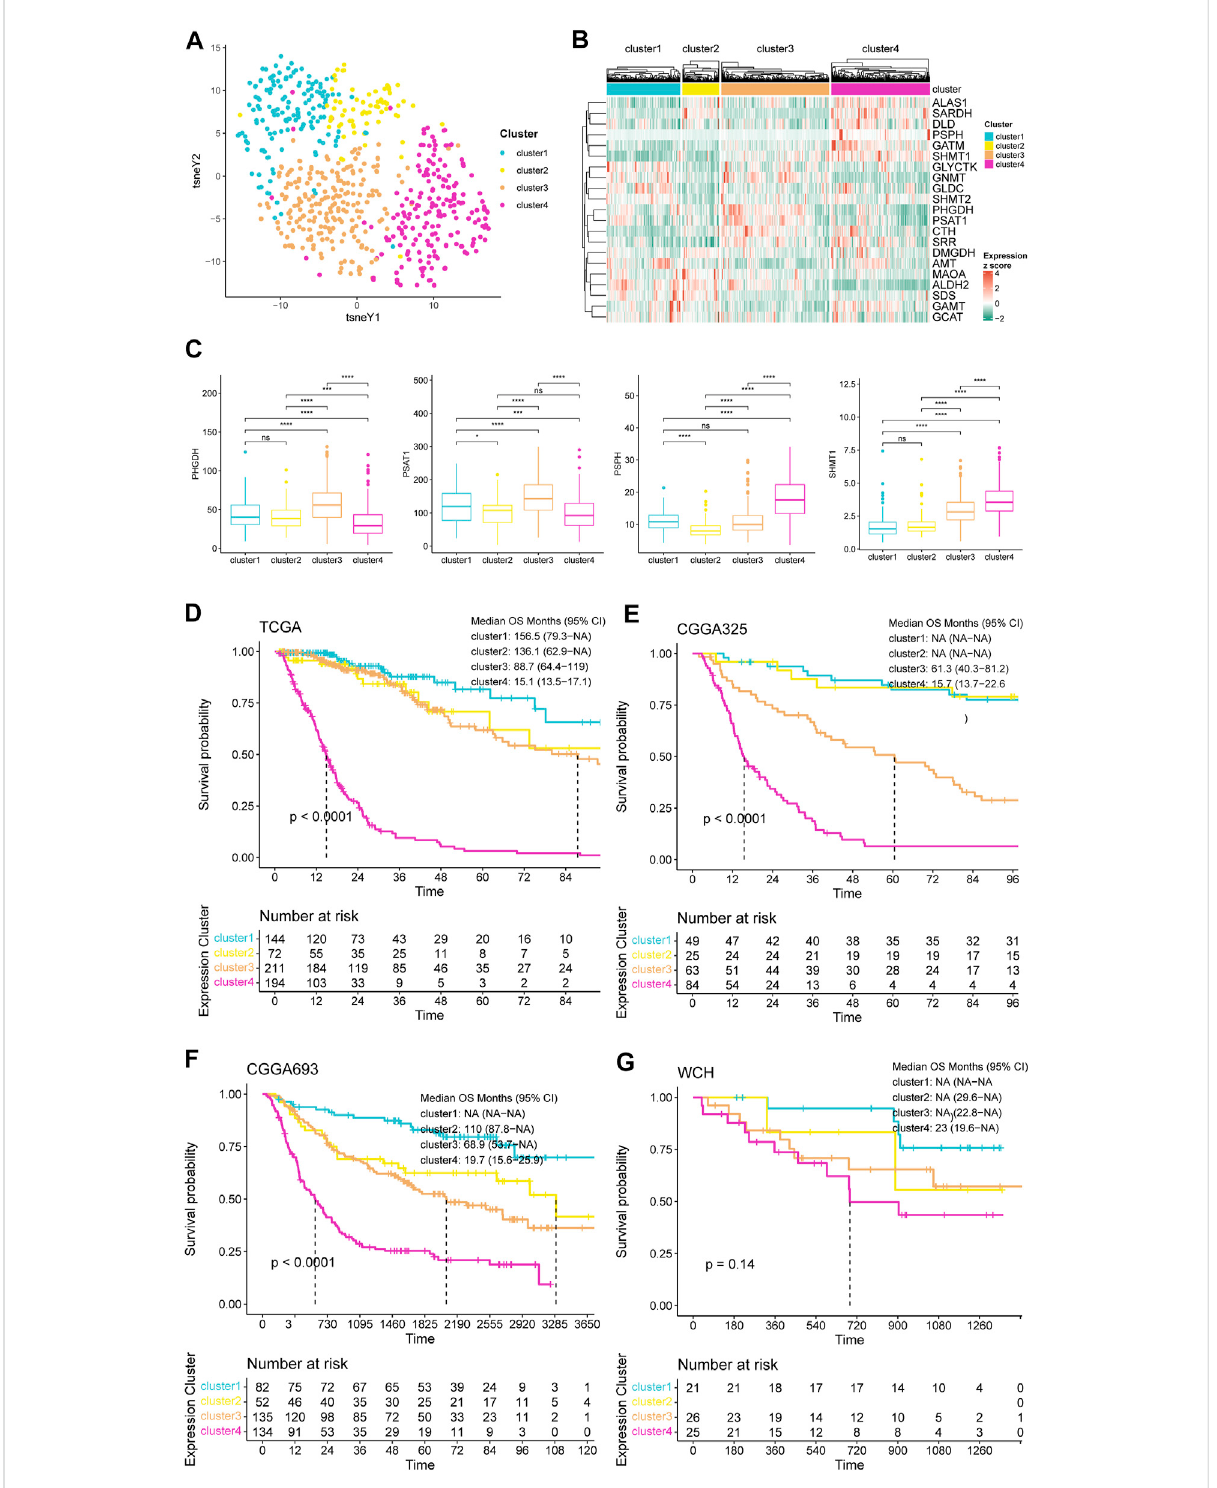
FIGURE 1 Clustering of gliomas based on expression pattern of SGMGs. (A) tSNE map for SGMGs expression patterns of four consensus clusters. (B) Heatmapfor expressionof21 SGMGs basedonfour clusters. (C) The expression levels ofPHGDH,PSAT1,PSPH, andSHMT1 among fourclusters. (D) K-M curves based on four consensus clusters in (D) TCGA, (E) CGGA325, (F) CGGA693, and (G) WCH